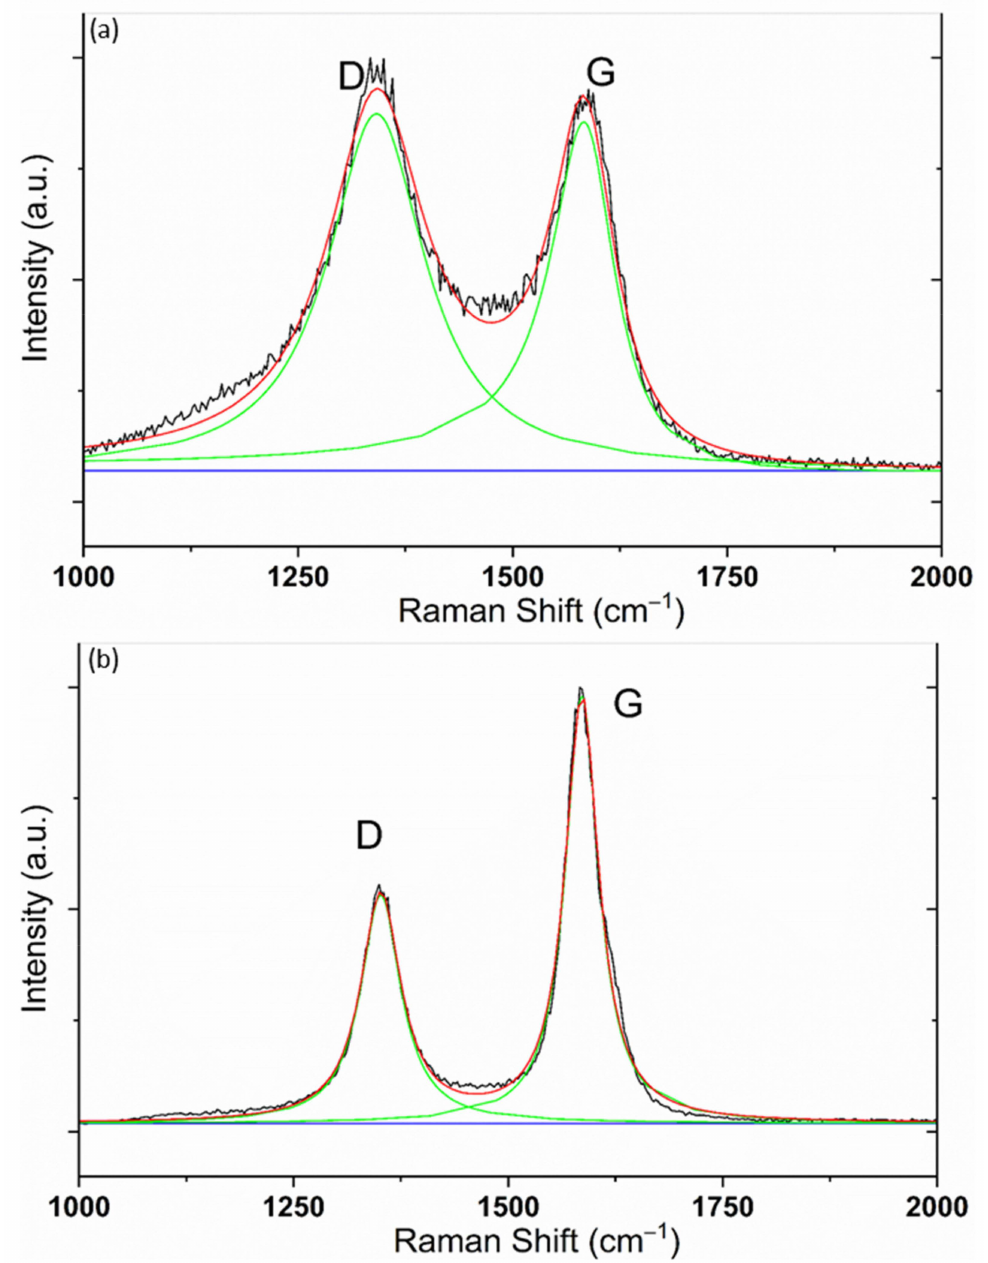
Figure 6. Raman curve fit for carbon samples ( a ) pre-annealing and ( b ) post-annealing at 1.626